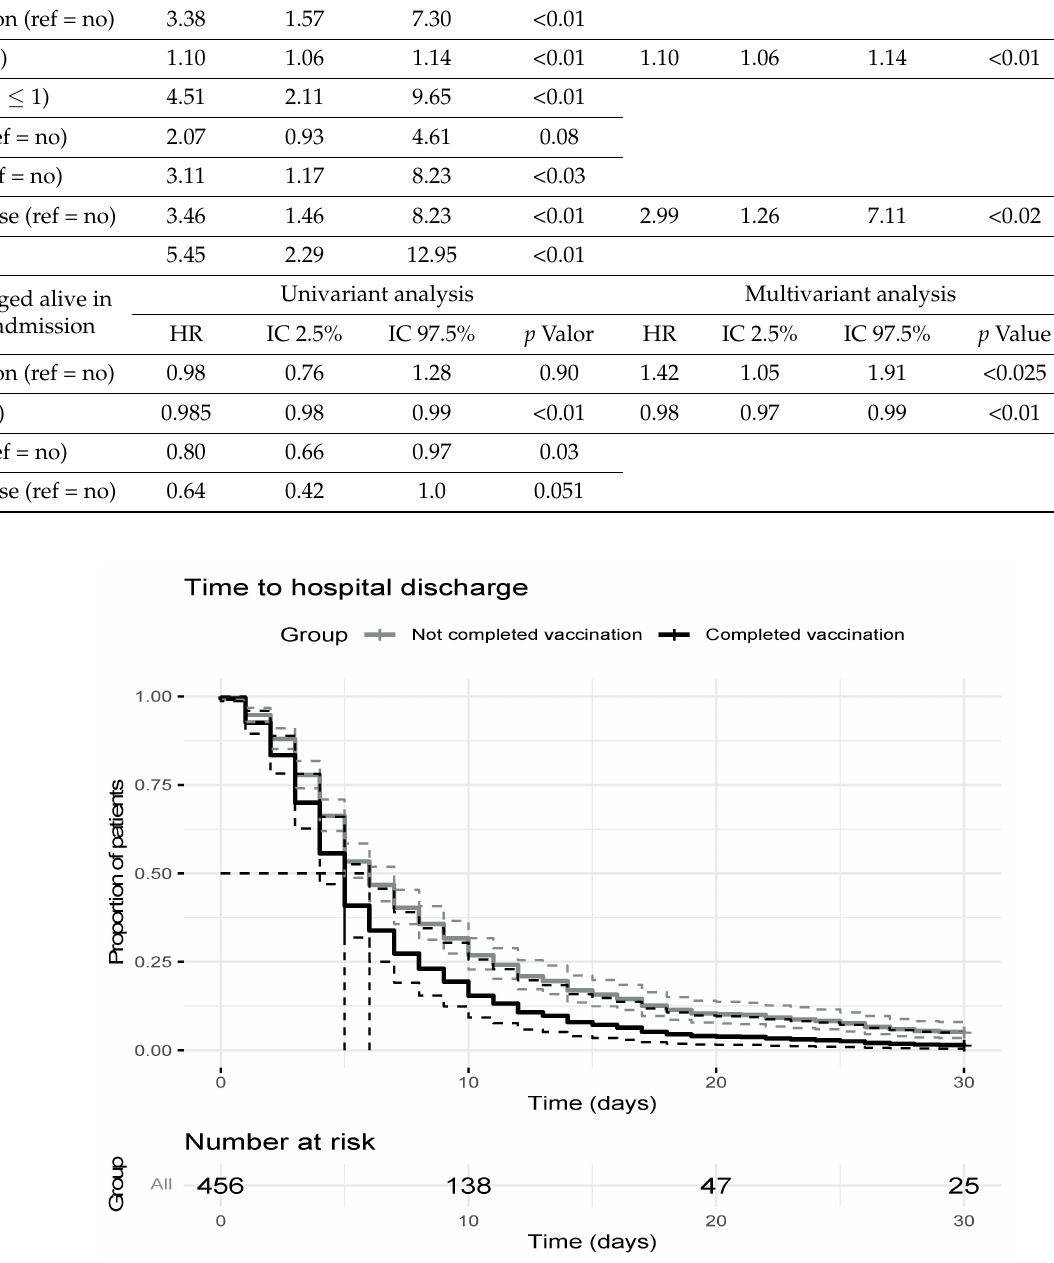
Figure 2. Time to hospital